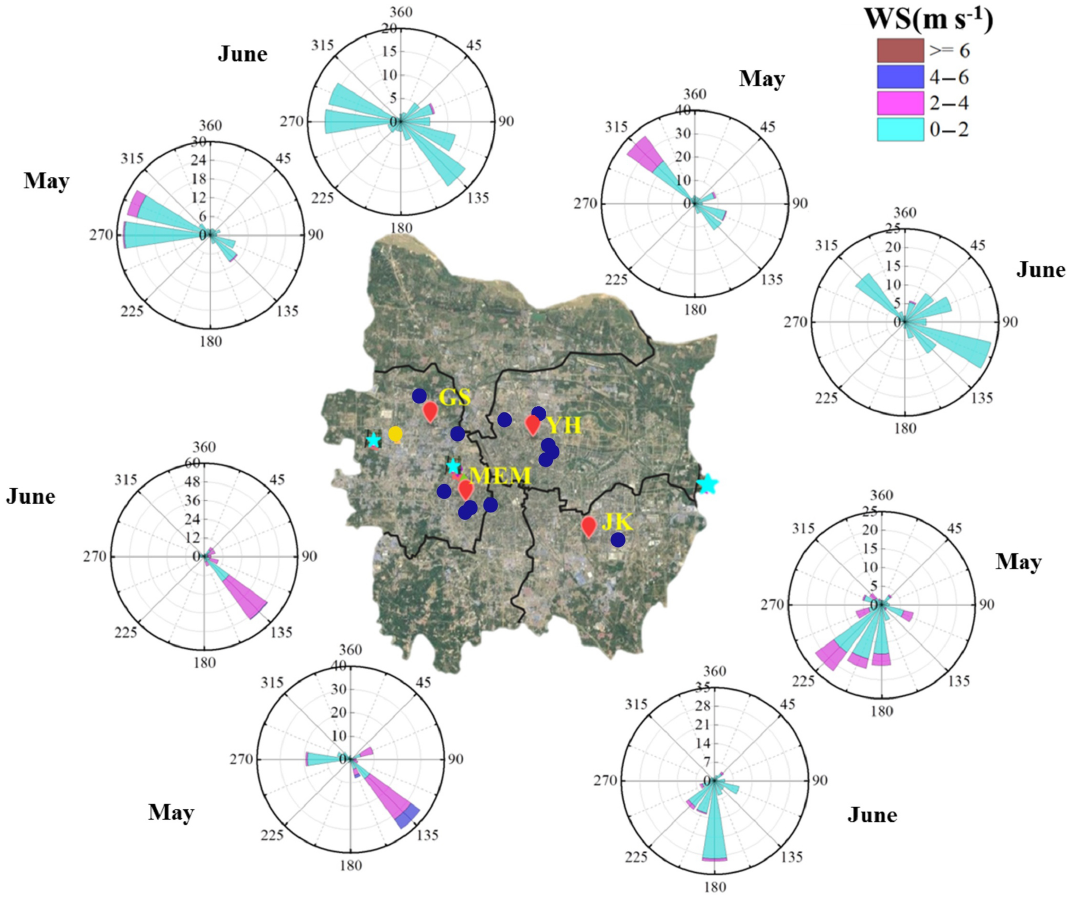
Figure 4. Wind rose plot showing wind sector frequency (%) of occurrence and associated wind speed (ms − 1 ) at each site in May and June (the wind distribution of the other three months is illustrated in Fig. S2), which were recorded by the anemometers placed at the same site as other air